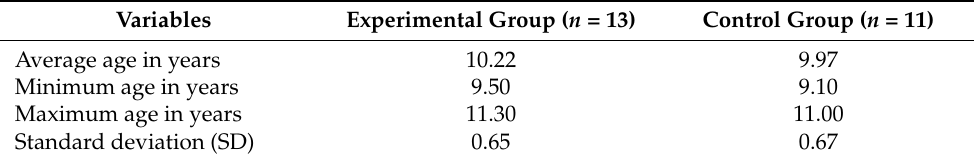
Table 1. Composition of experimental and control groups according to age. Variables Experimental Group ( n = 13) Average age in